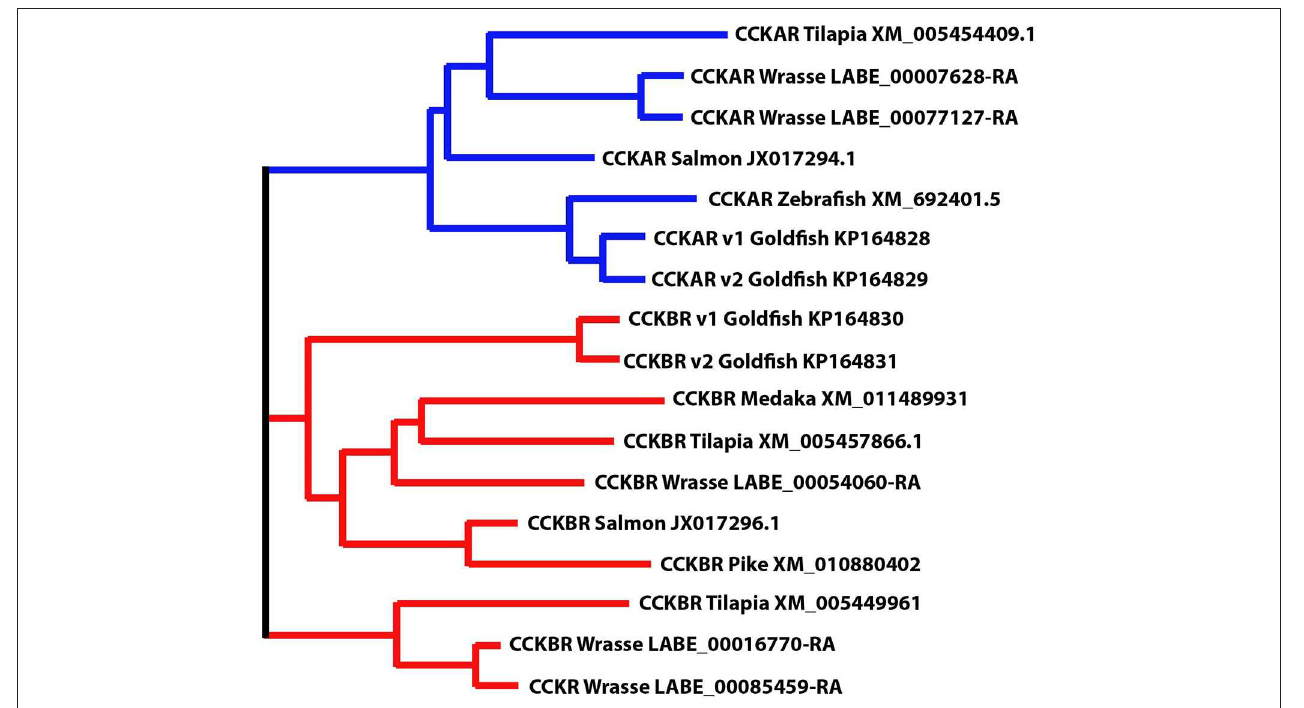
FIGURE 4 | Phylogenetic position of ballan wrasse CCK receptors (CCKAR and CCKBR). The figure shows the phylogenetic relationship between the annotated CCK-receptor nucleotide sequences in tilapia, salmon, zebrafish, goldfish, medaka and pike to wrasse, generated using the Multiple Sequence Comparison by Log- Expectation (MUSCLE)